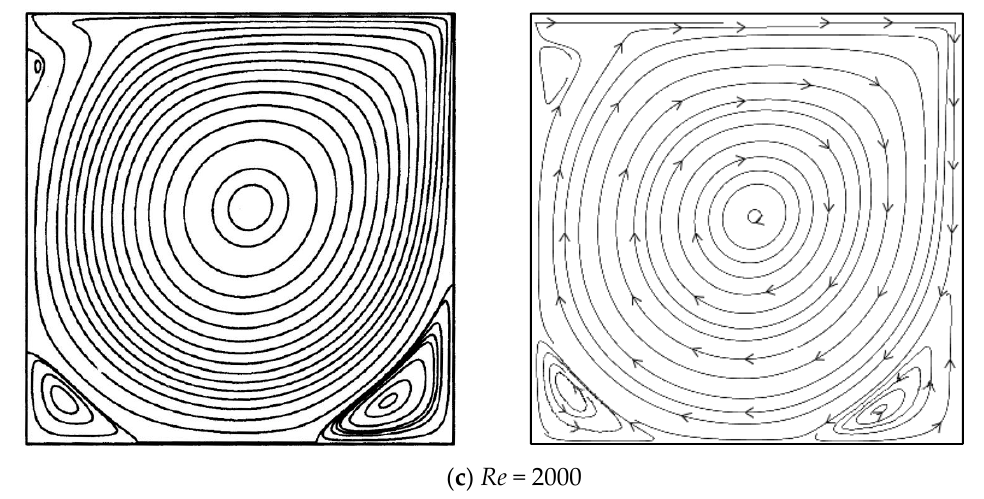
Figure 8. Lid driven cavity flow streamline diagrams with different Re .